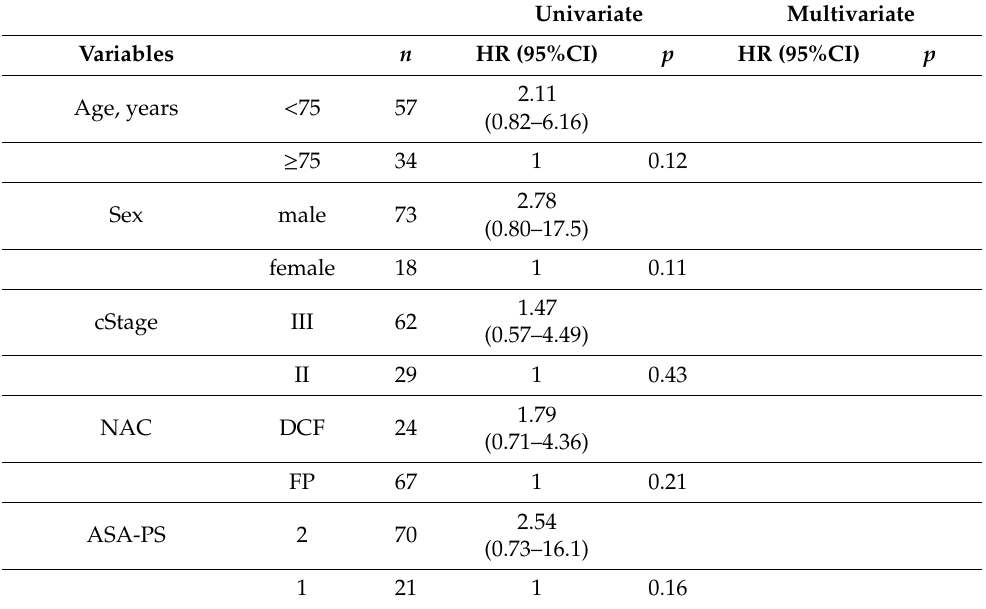
Table 3. Cox proportional hazard model of clinical characteristics of overall survival in the elderly group using uni- and multivariate